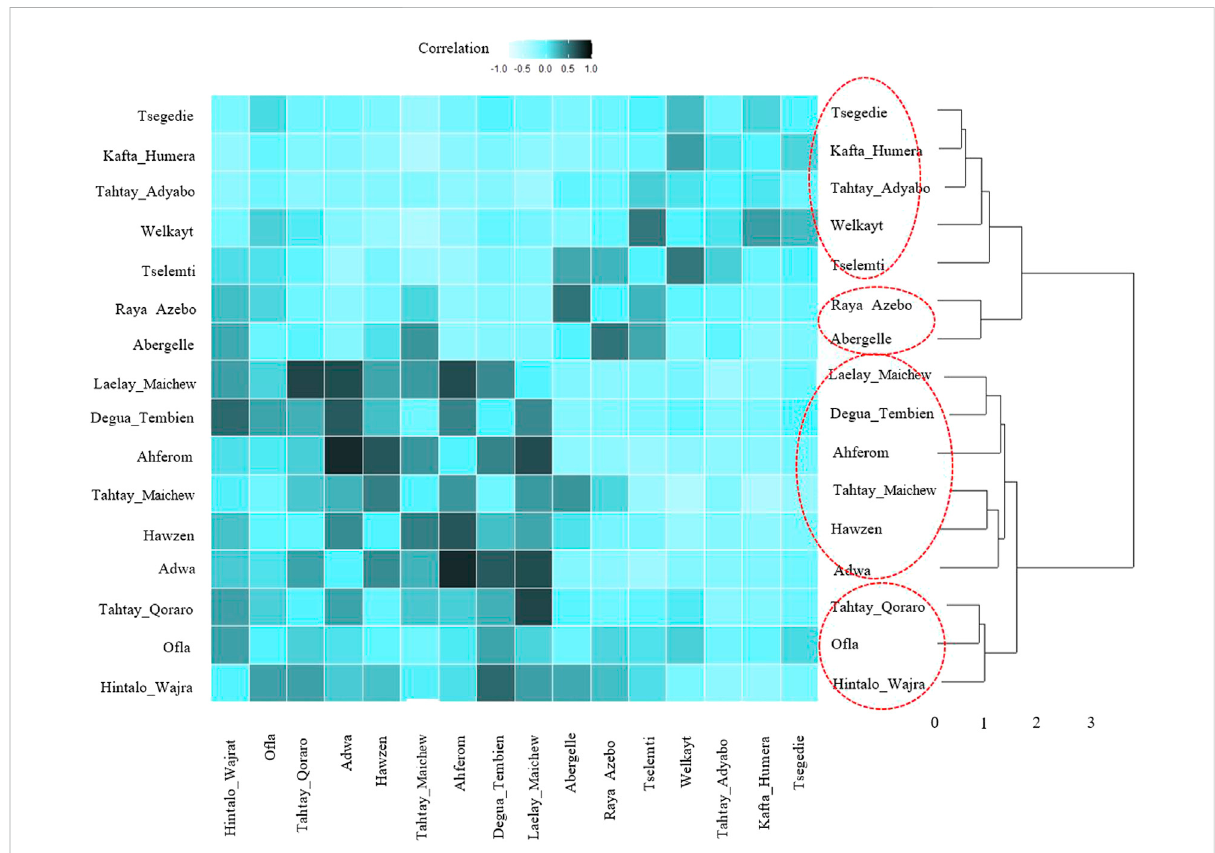
FIGURE 11 Dendrogram and heatmap of pairwise Pearson correlation coef fi cient between suitability maps for individual population.